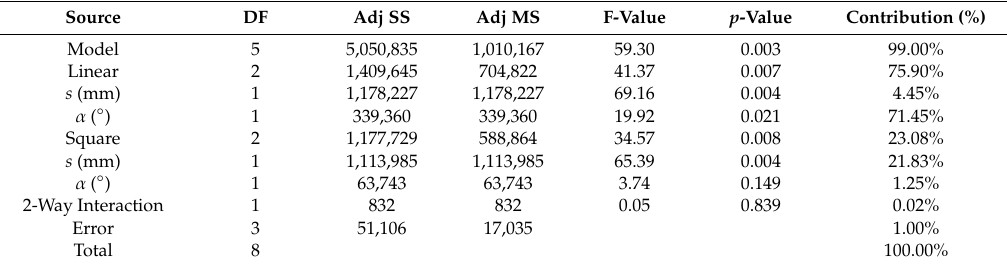
Table 8. The output from the analysis of variance for the total machining force F